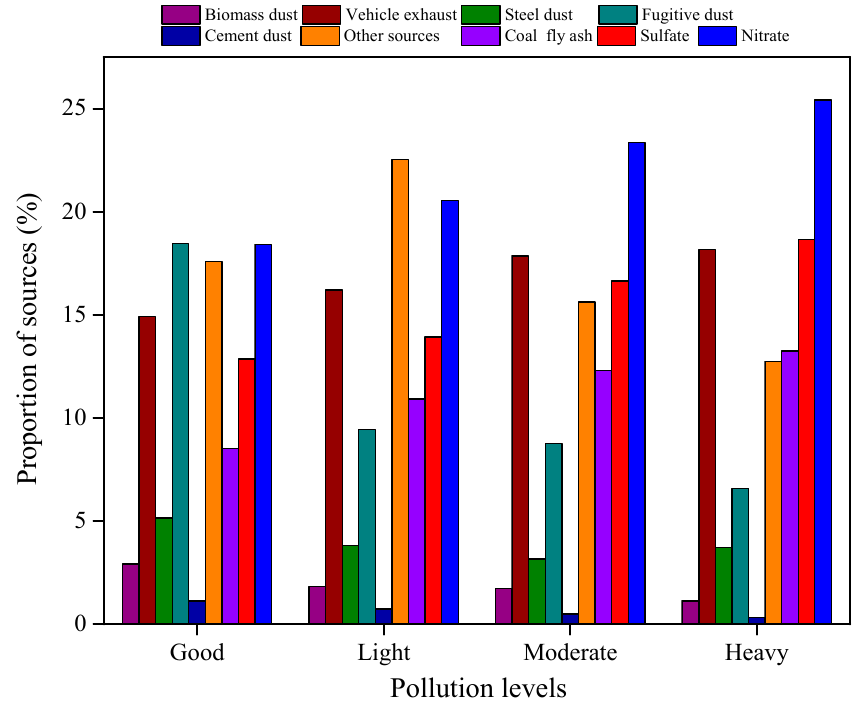
Figure 14. Trend of source contribution in four pollution days in Jinan.